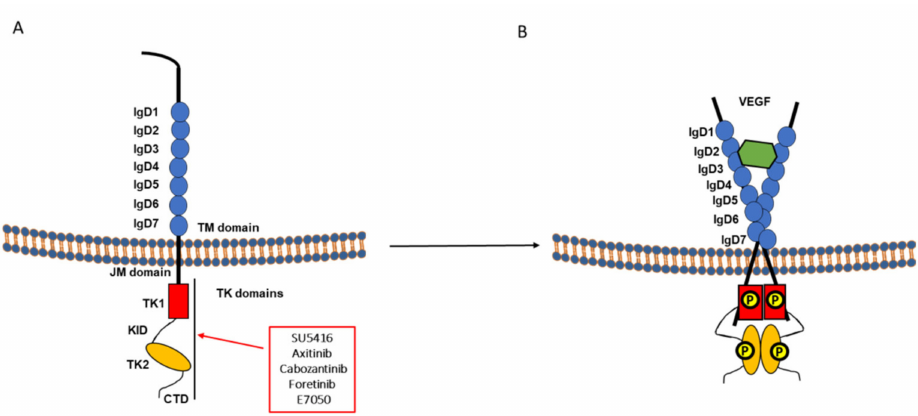
Figure 4. VEGFR structure and activation. ( A ) ECD of VEGFR is composed of a single peptide that consists of seven Ig-like subdomains (IgD1 ∼ 7), transmembrane domain (TM), juxtamembrane domain (JM), tyrosine kinase 1 domain (TK1) including ATP binding domain, kinase insert domain (KID), tyrosine kinase 2 domain (TK2), and a flexible C-terminal domain (CTD). ( B ) VEGFs binding to VEGFR require two Ig-like subdomains 2 and 3 (IgD2 and IgD3), and the stabilization of dimers and VEGF-mediated activity required Ig-like subdomains 4 ∼ 7 (IgD4 ∼ 7). This mediates tyrosine residues phosphorylation on the TKD and downstream signaling pathways activation. VEGFR-tyrosine kinase inhibitors occupy the ATP-binding pocket of the kinase domain to exhibit its inhibitory function.